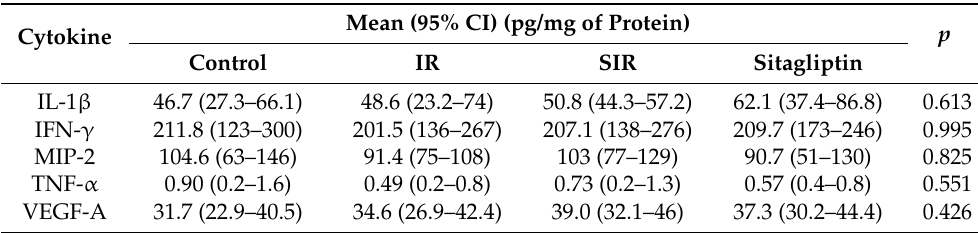
Table 4. Effect of ischemia/reperfusion (IR) injury and/or sitagliptin on hepatic concentration of selected cytokines and growth factors.